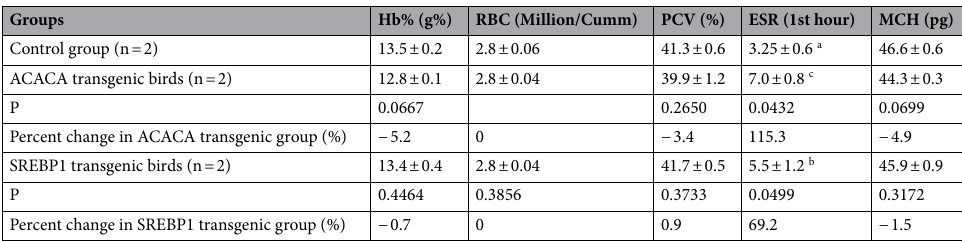
Table 4. Blood parameters (Mean ± standard deviation) in female transgenic and control birds at 26 weeks of age during 1st generation. Different superscripts (column-wise) indicate significant differences. The RBC indices viz. RBC count, Haemoglobin (Hb)%, packed cell volume (PCV), erythrocyte sedimentation rate (ESR) and mean corpuscular haemoglobin (MCH) were measured in transgenic as well as control birds to compare between transgenic and control groups.